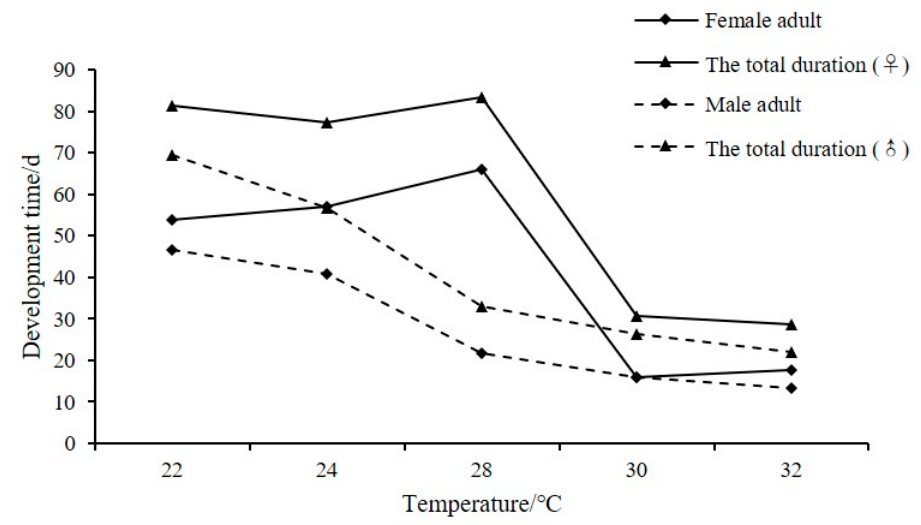
Figure 2. Relationship between temperature and the developmental time of C. malaccensis.